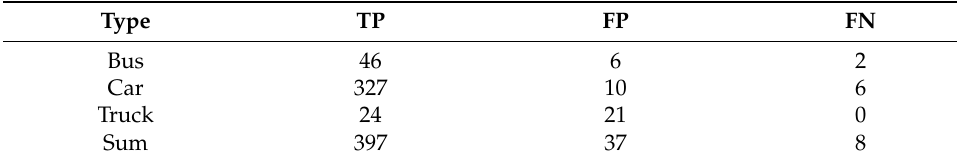
Table 7. Faster R-CNN model detection results.